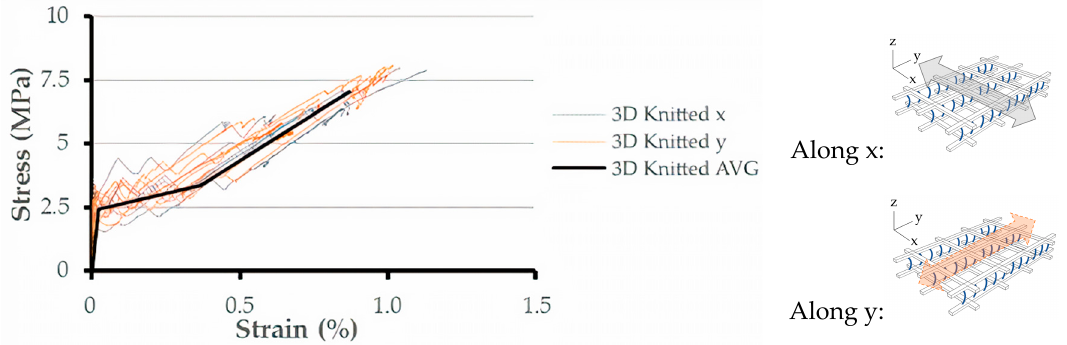
Figure 10. All tensile experimental curves in x- and y-direction for the knitted 3D TRC layup, as well as averaged as averaged curve. Table 3. Averaged tensile experimental parameters for the knitted 3D TRC layup, as well as model predictions.